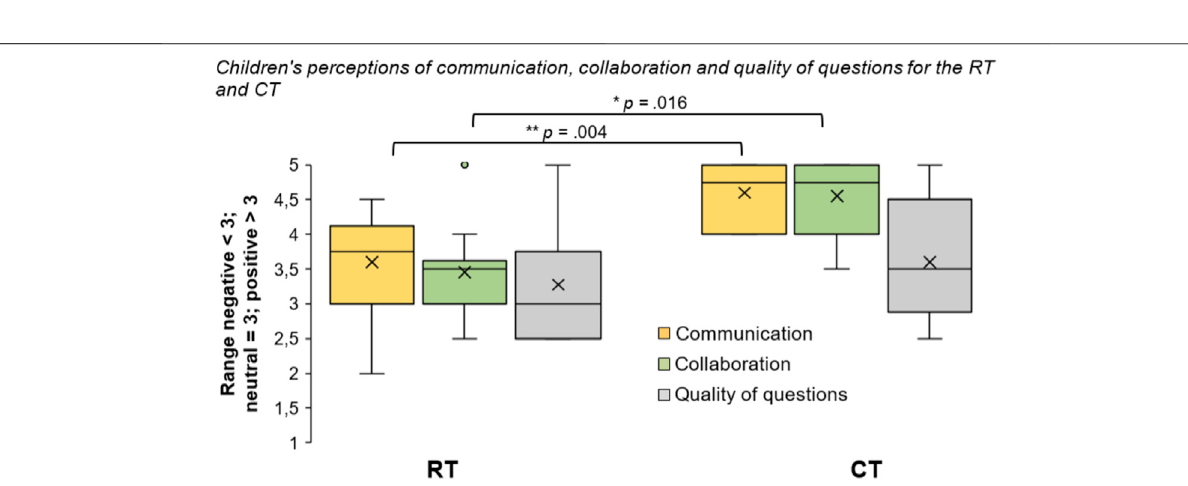
Frontiers in Robotics and AI |